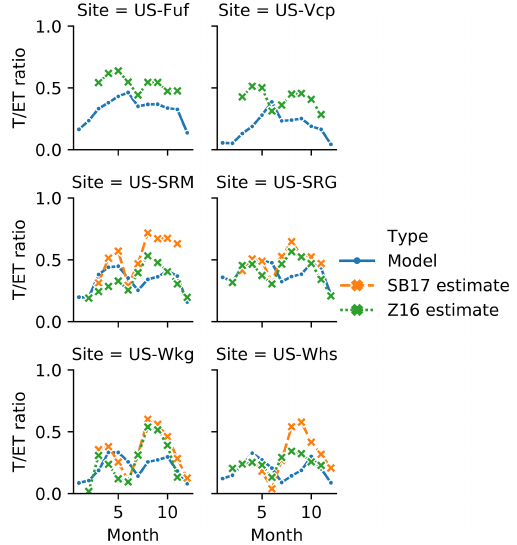
Figure 6. Comparison of modelled and data-derived estimates of mean monthly T / ET ratios for each site. Forest site (US-Fuf and US-Vcp) T / ET estimates are derived using the method of Zhou et al. (2016 – Z16 – green curve). Monsoon low-elevation grass- and shrub-dominated site T / ET estimated are based on both Zhou et al. (2016) and Scott and Biederman (2017 – SB17 – orange curve). Blue curves show the model ratios at each site. Please see Sect. 2.3.1 for details on methods for data-derived T / ET